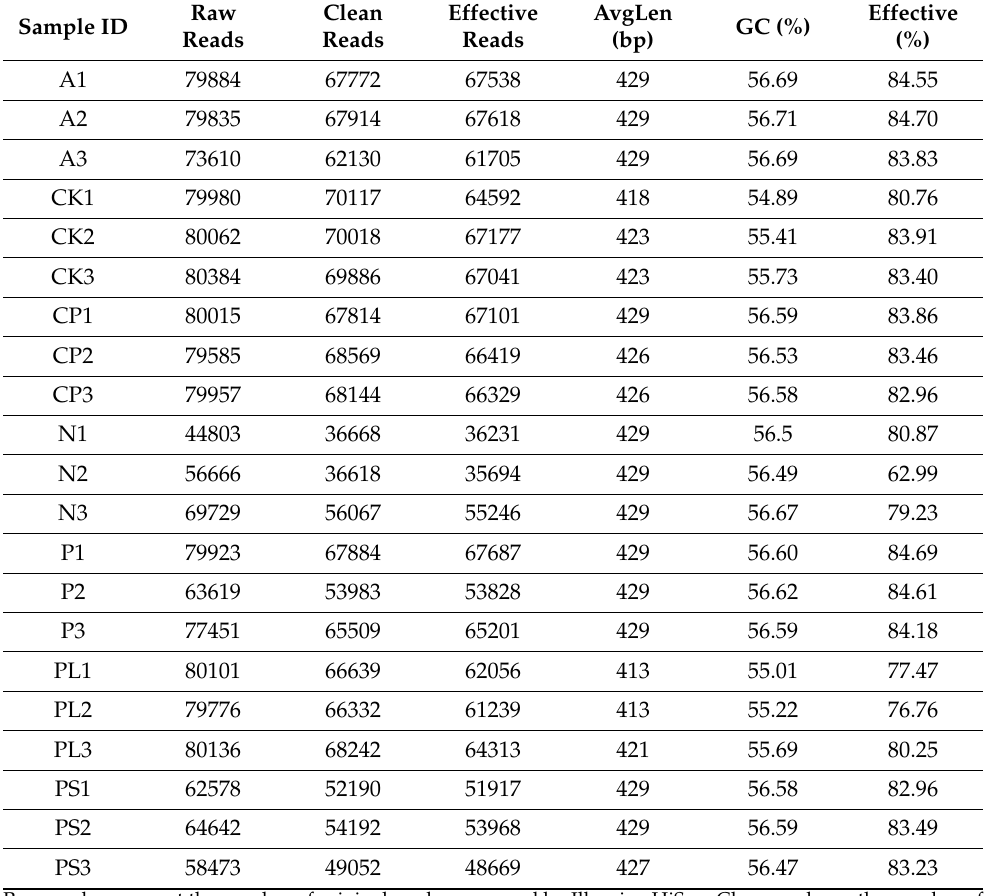
Table 1. Summary of sequence statistics for the Illumina HiSeq runs of all samples.